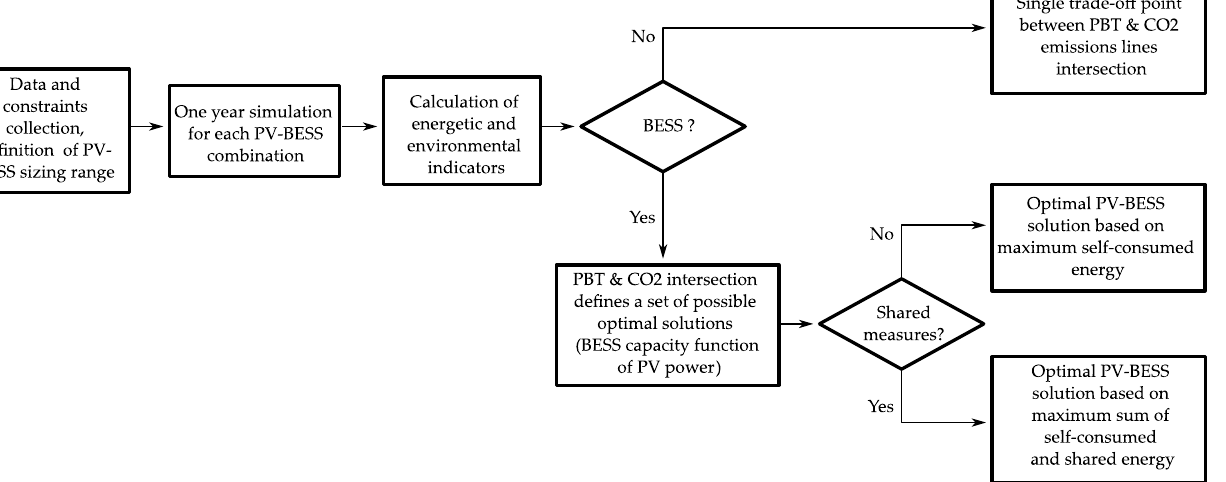
Figure 3. Flowchart representing the procedure for selection of optimal PV-BESS sizing.